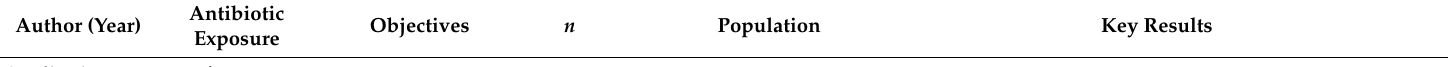
Table 1. Cohort studies of gut dysbiosis induced by antibiotic and nonantibiotic